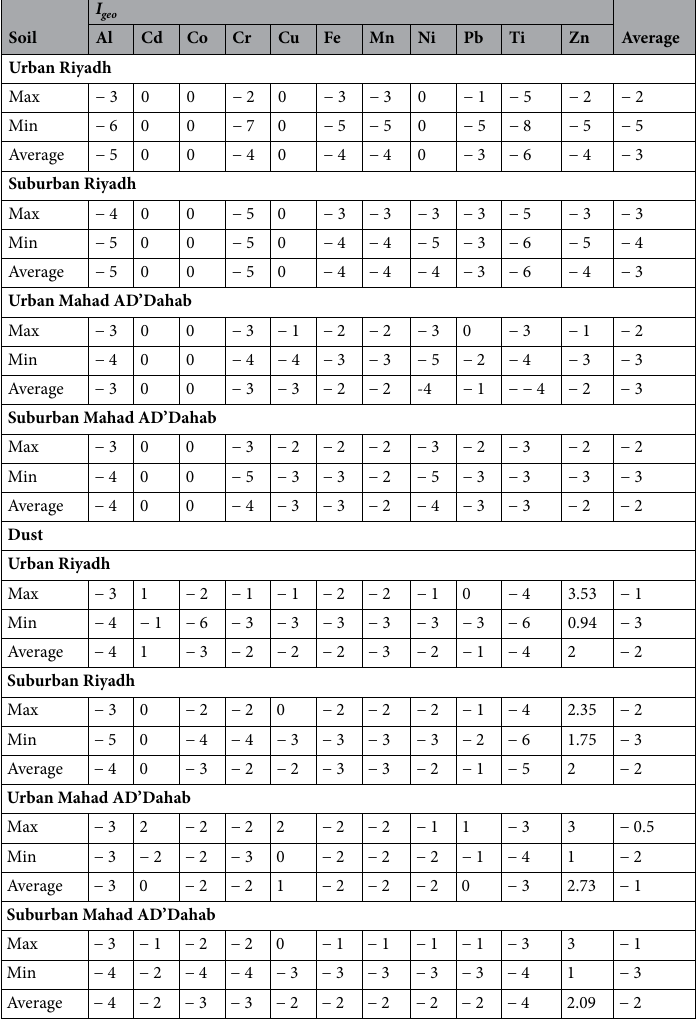
Table 4. The calculated data of the I geo for heavy metals of soil and dust